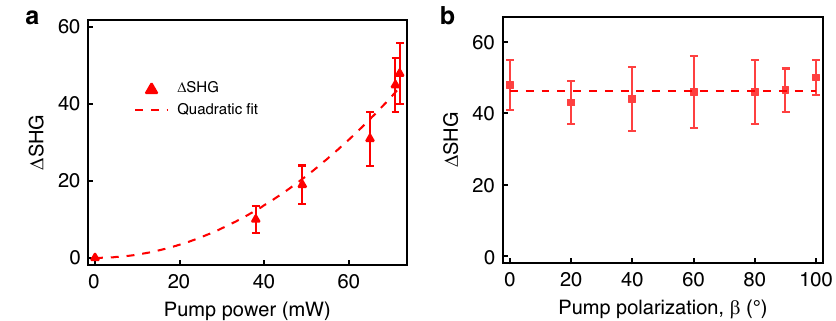
Fig. 4 Pump power and pump polarization dependence. a Quadratic pump power dependence of pump-induced SHG. The dashed curve is a quadratic fi t. The relatively large error bars re fl ect the fl uctuations of the pump-induced SHG signal, relatively weak in comparison with the surface SHG. b The pump- induced SHG as a function of pump polarization, β . The dashed-line is a horizontal line